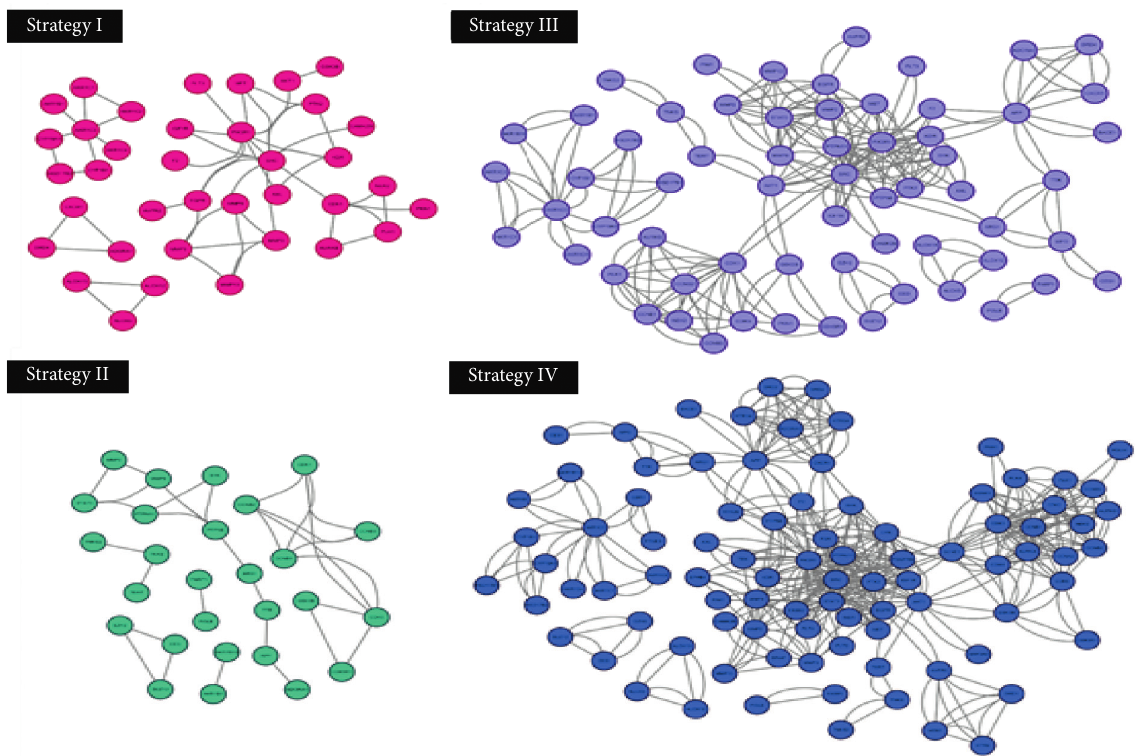
Figure 3: Potential protein-protein interaction networks in four herbal strategies with clarified